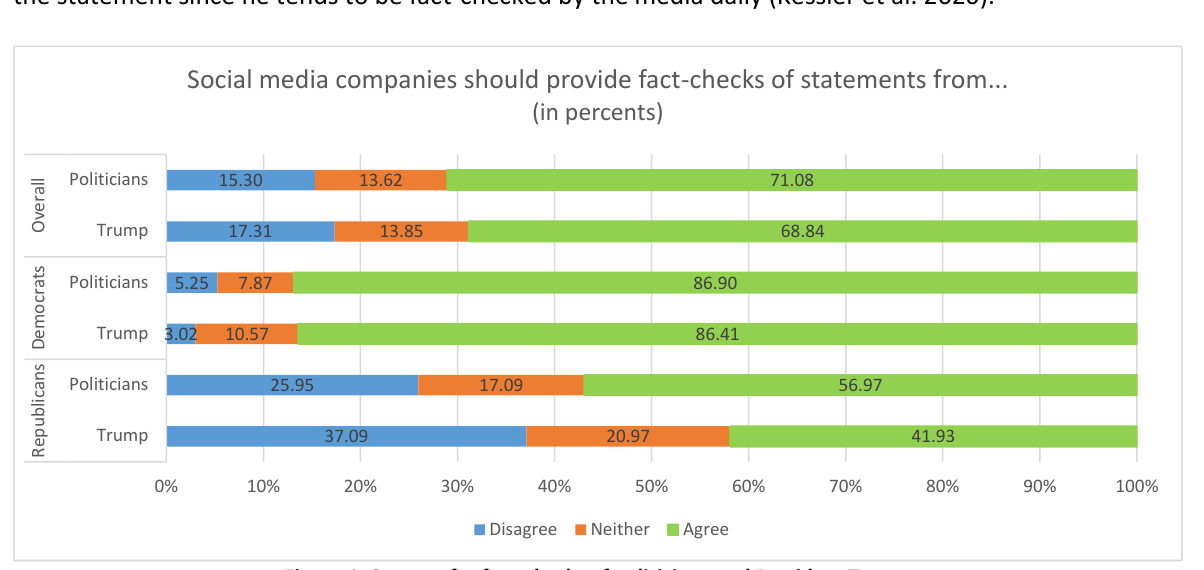
Figure 1. Support for fact-checks of politicians and President